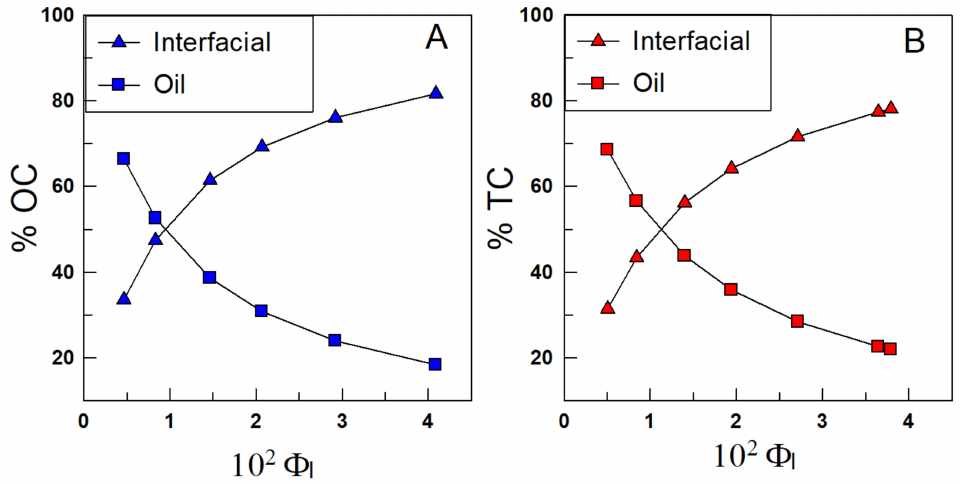
Figure 4. Variation in the percentages of OC ( A ) and TC ( B ) with Φ I obtained in intact 4:6 corn oil-in-water emulsions at T = 25 ◦